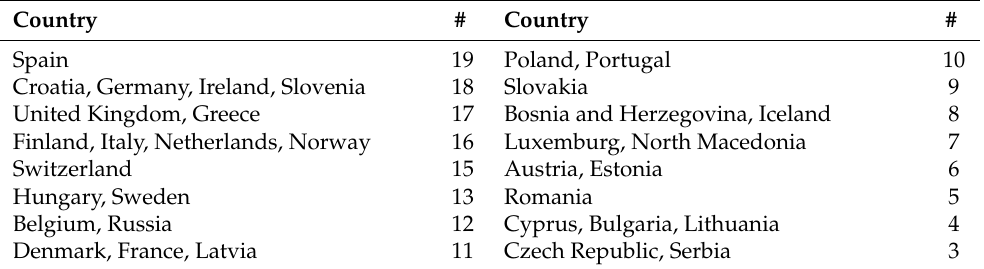
Table 1. Countries and respective number of years for which data are available.